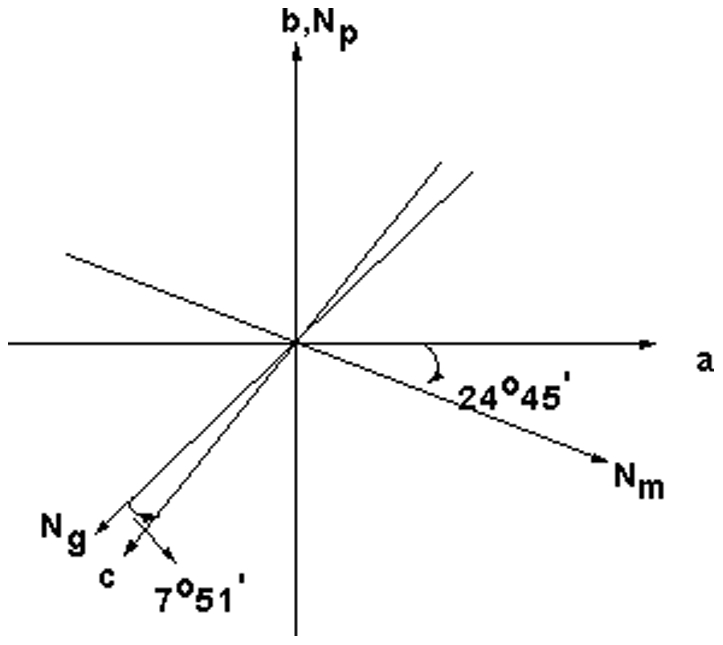
Angular relation between the optical indicatrix axes and the crystallographic axes of MgMoO4 crystal.